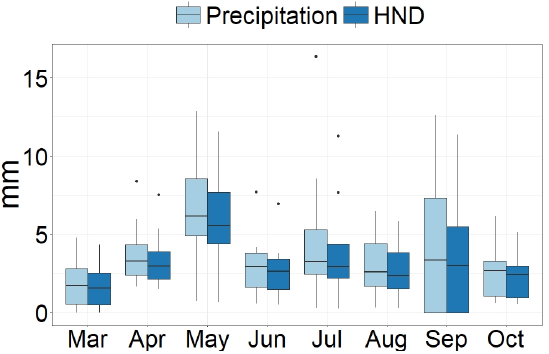
Figure 5. Monthly precipitation and factor HND at Sterling Ranch, 2010‒2017.